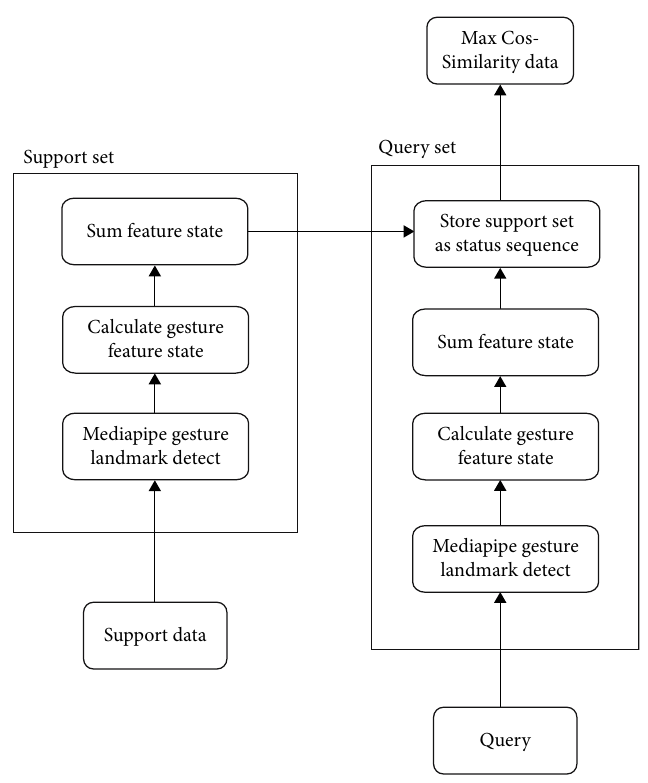
Figure 2: Structure of continuous gesture recognition